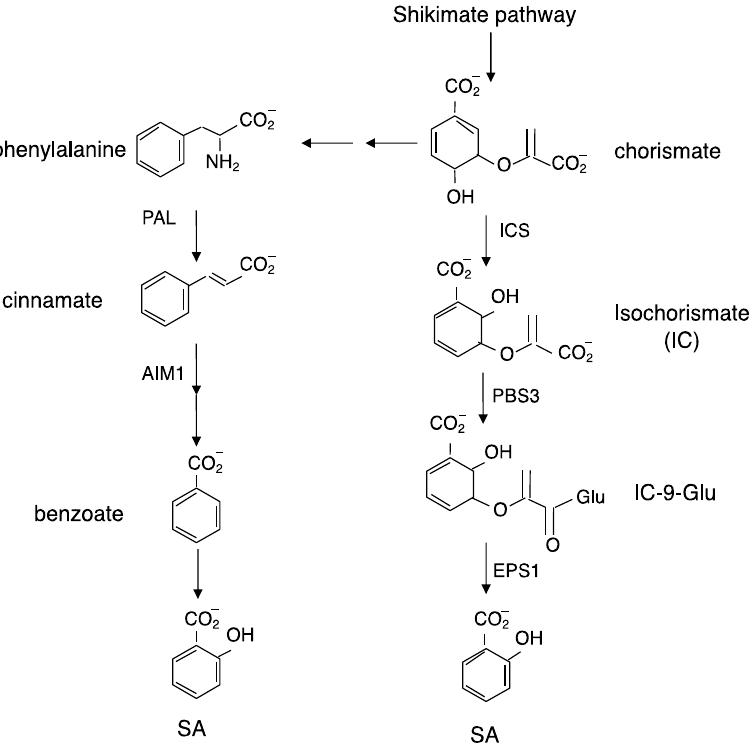
Figure 1. Pathways of SA biosynthesis in plants.